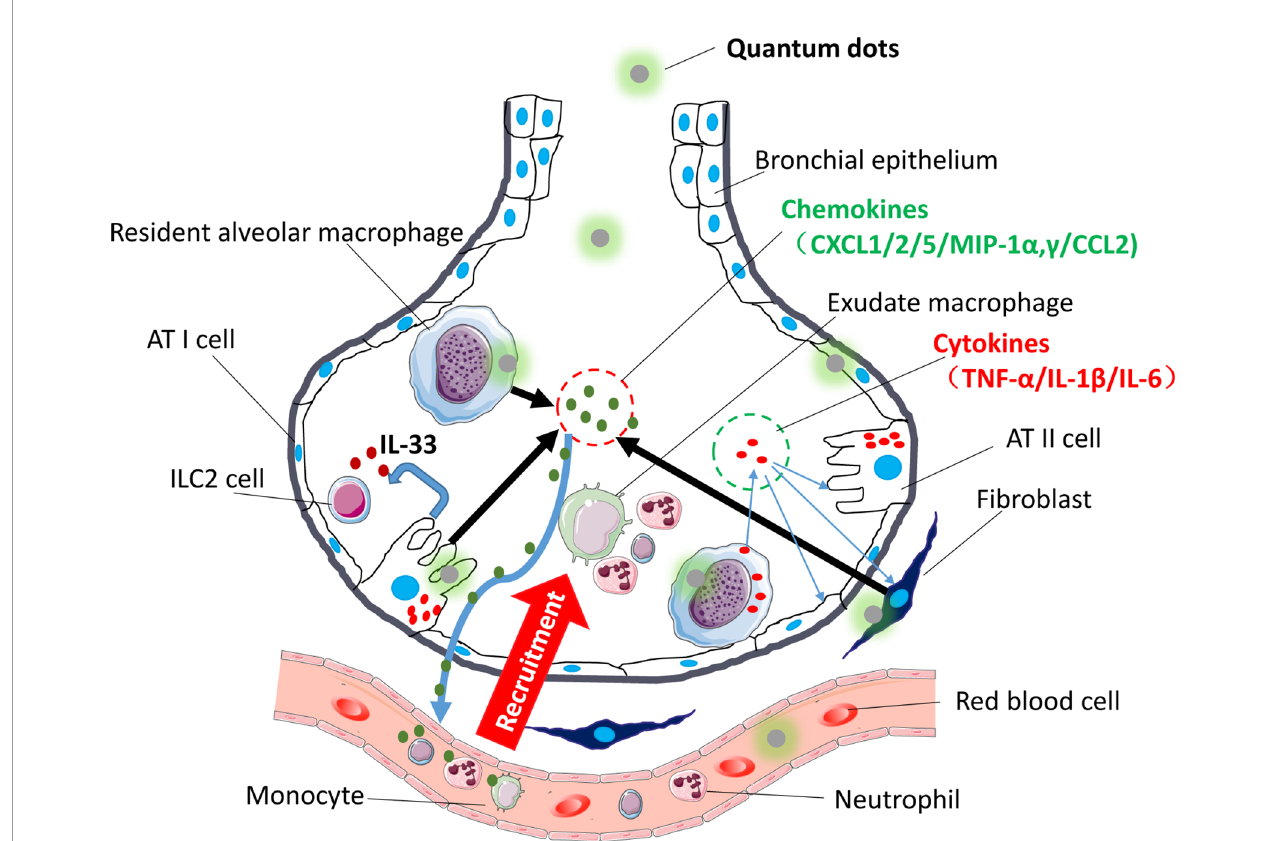
FIGURE 2 | Immune modulatory effects of QDs on the respiratory system. The picture shows that after being exposed to QDs, resident pulmonary macrophages, lung epithelial cells, and fi broblast swallowed QDs, and then QDs would activate in fl ammatory-related pathway like TLR signaling, which promoted cells to release proin fl ammatory cytokines (TNF- a , IL-1 b , and IL-6) and chemokines (CXCL-1/2/5/MIP-1 a , g /CCL-2). Sequentially neutrophils would be recruited fi rstly, and then monocyte and adaptive immune T cells would follow. Besides, QDs activated AT II cells and released IL-33 which activated ILC2